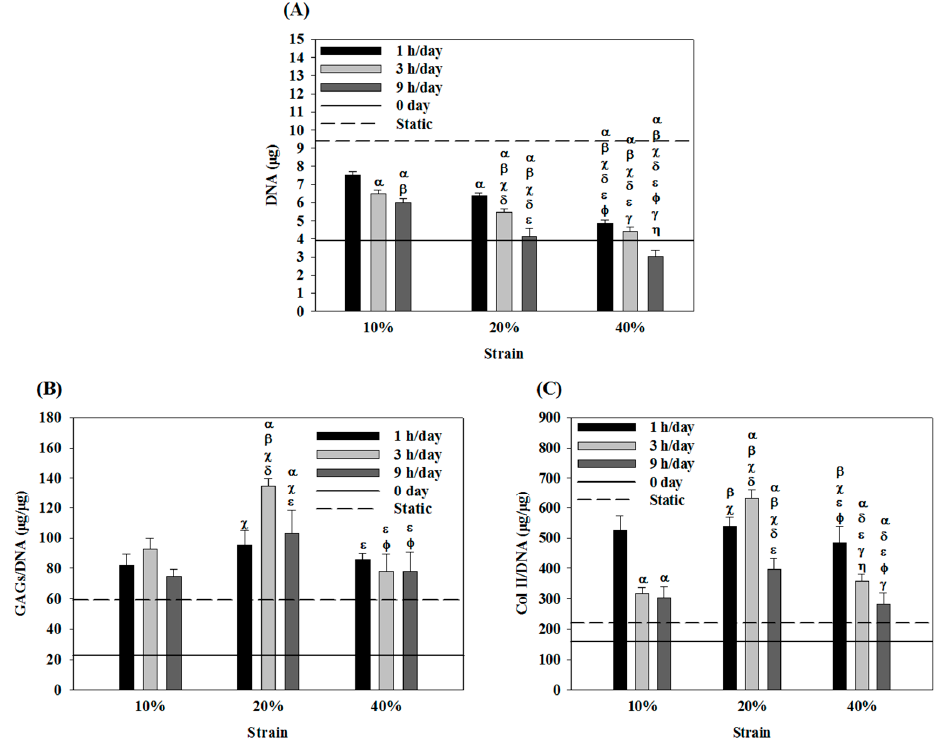
Figure 2. The proliferation and extracellular matrix (GAGs and Col II) production when chondrocytes were cultured in cryogel scaffolds under different cyclic compressive loading conditions. The DNA ( A ), GAGs/DNA ( B ) and Col II/DNA ( C ) contents of cells dynamically cultured for 14 days at 1 Hz were shown and compared with day 0 (solid lines) and static culture (dotted lines) for 14 days. The groups under dynamic culture with 10% (40%) strain and 1 h/day (3 h/day) duration are termed D11 (D43) etc. α p < 0.05 with D11; β p < 0.05 compared with D13; χ p < 0.05 compared with D19; δ p < 0.05 compared with D21; ε p < 0.05 compared with D23; Φ p < 0.05 compared with D29; γ p < 0.05 compared with D41; η p < 0.05 compared with D43. GAGs: Glycoaminoglycans; Col II: Type II